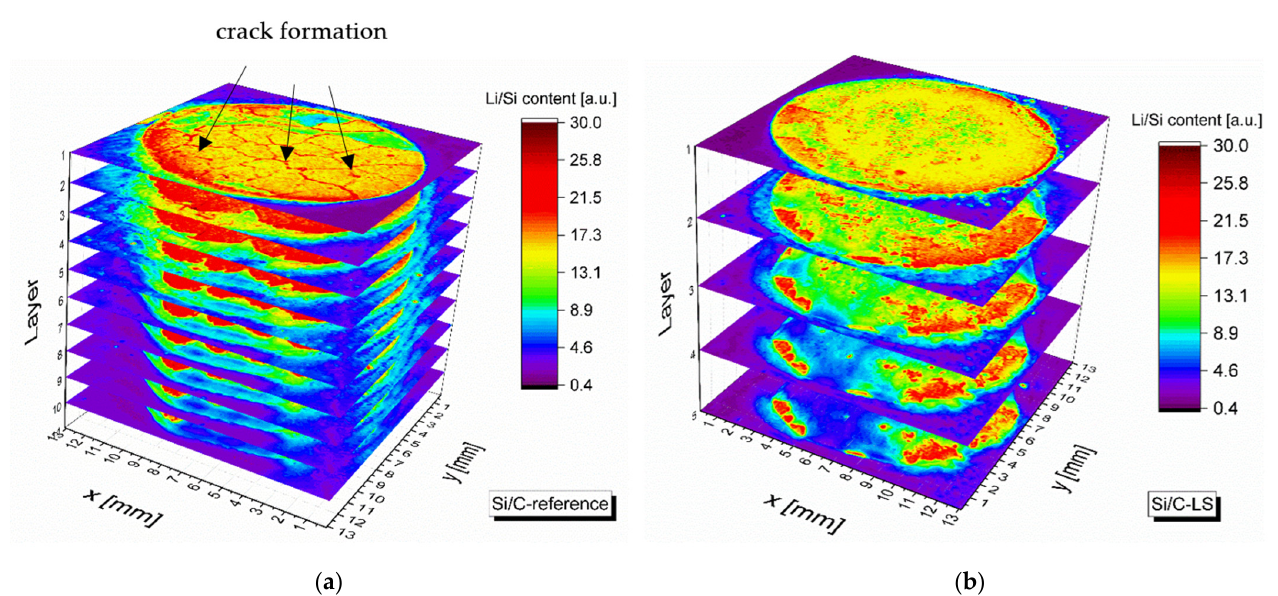
Figure 11. Post-mortem qualitative analysis of the electrochemically cycled electrodes by LIBS: ( a ) reference electrode without laser patterning and ( b ) laser patterned electrode.